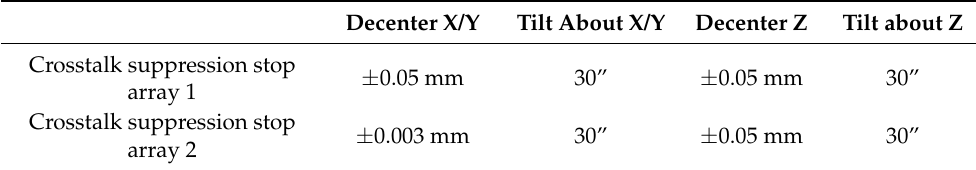
Table 4. The positioning tolerance of 2 crosstalk suppression stop